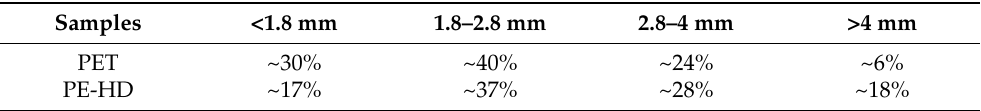
Table 1. The percentage share of each fraction in the total mass of polymers investigated after grinding and sieving.